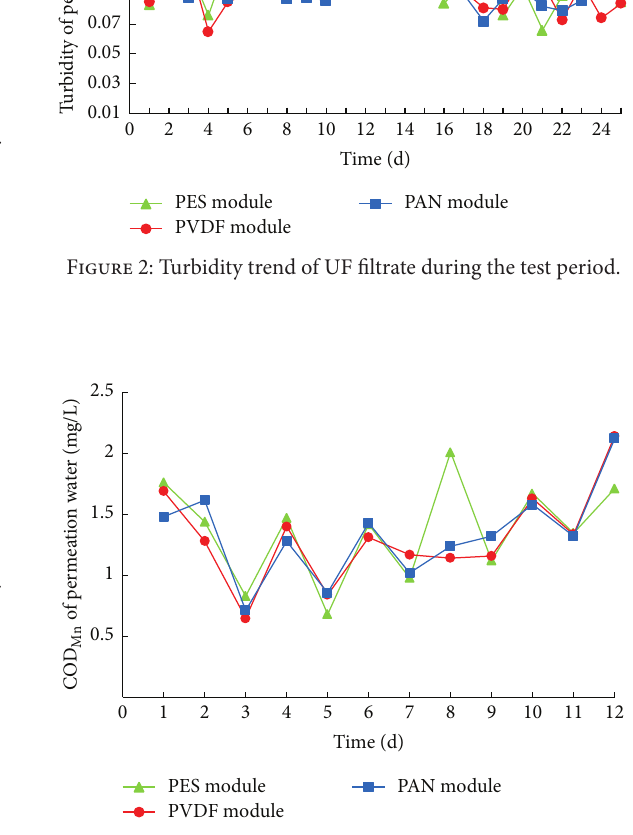
Figure 3: COD Mn trend of UF filtrate during the test period.